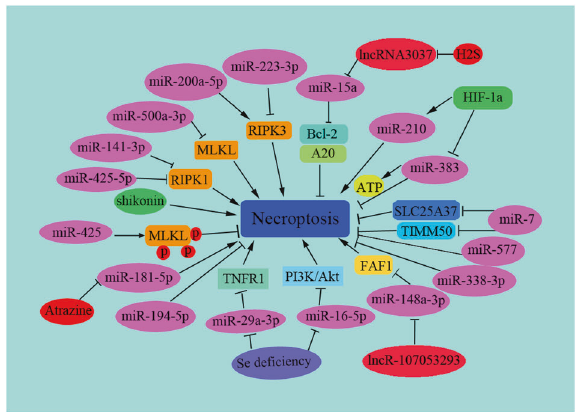
Fig. 1 Necroptosis is regulated by ncRNAs. Necroptosis is regulated by noncoding RNAs including lncRNAs, miRNAs, and several important target proteins and signaling pathways are